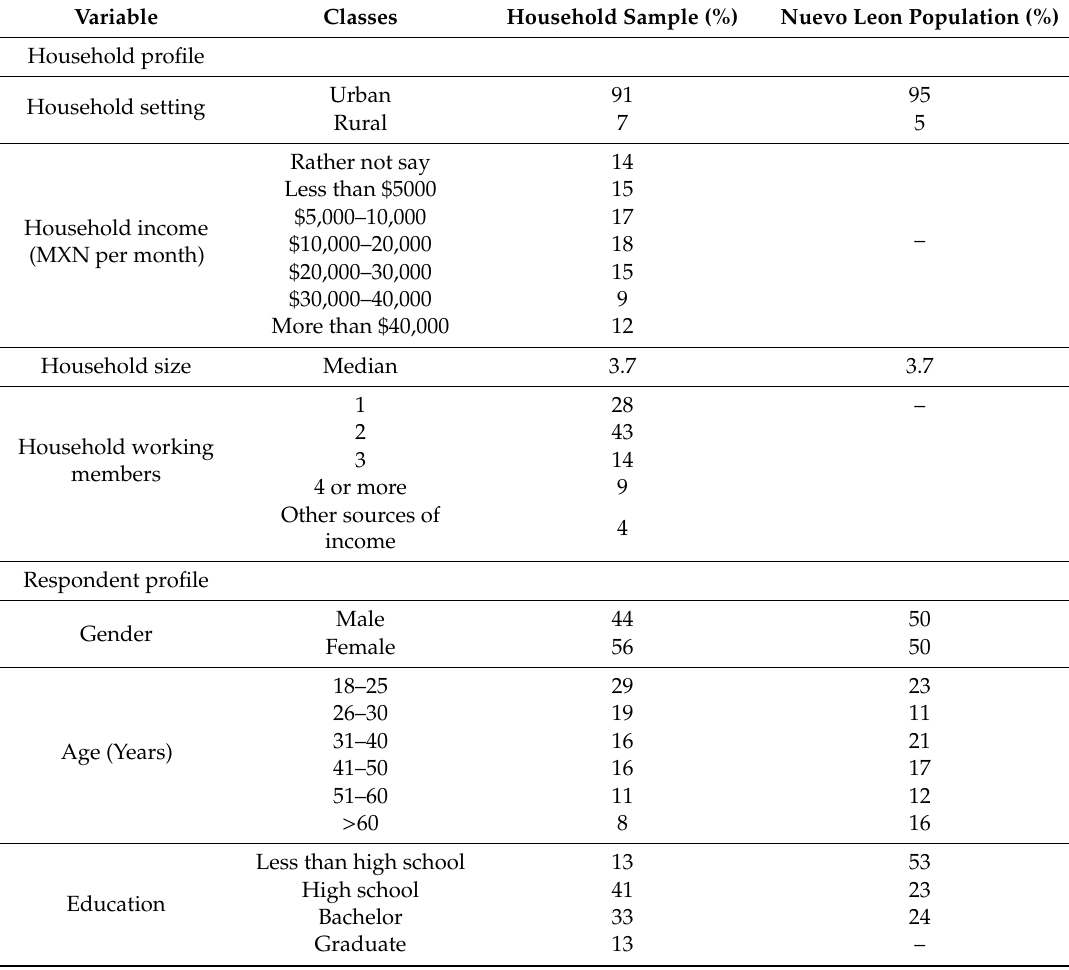
Table 2. Household and respondent